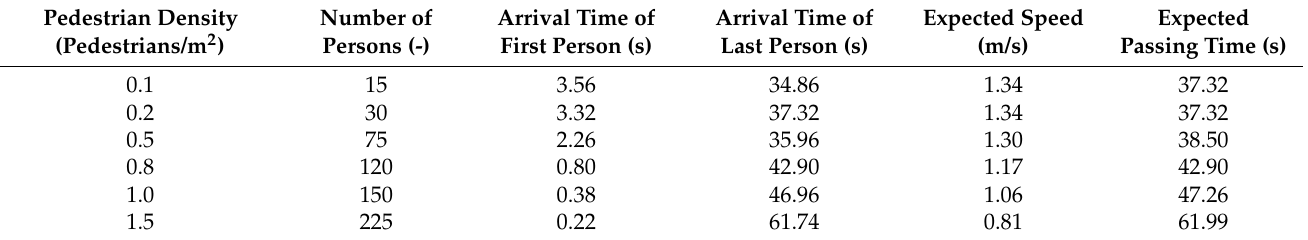
Table 2. Parameters of considered